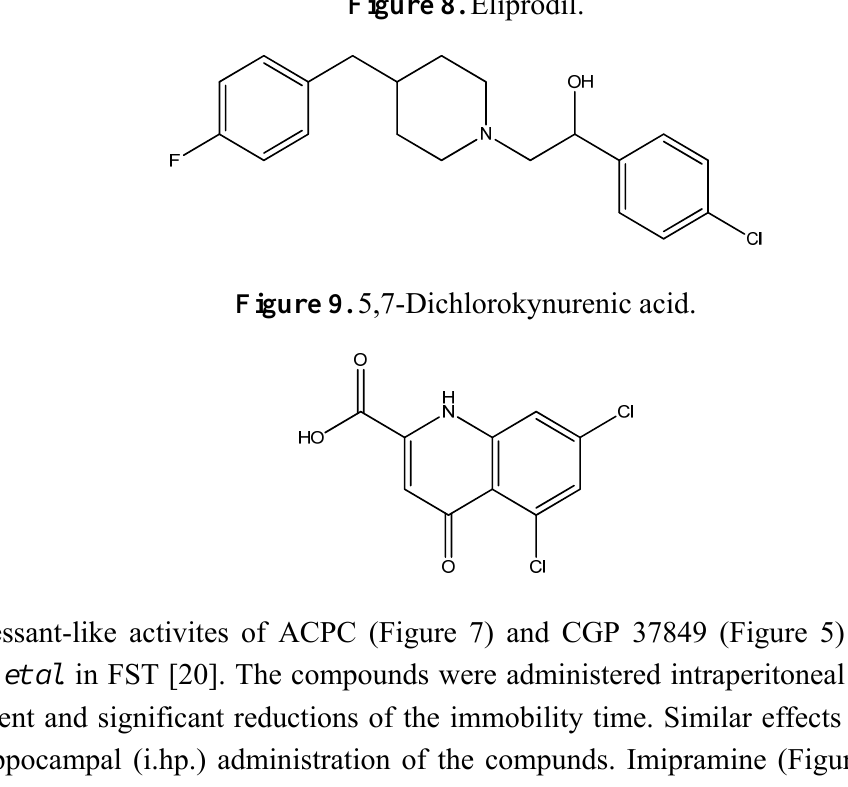
Figure 8. Eliprodil.